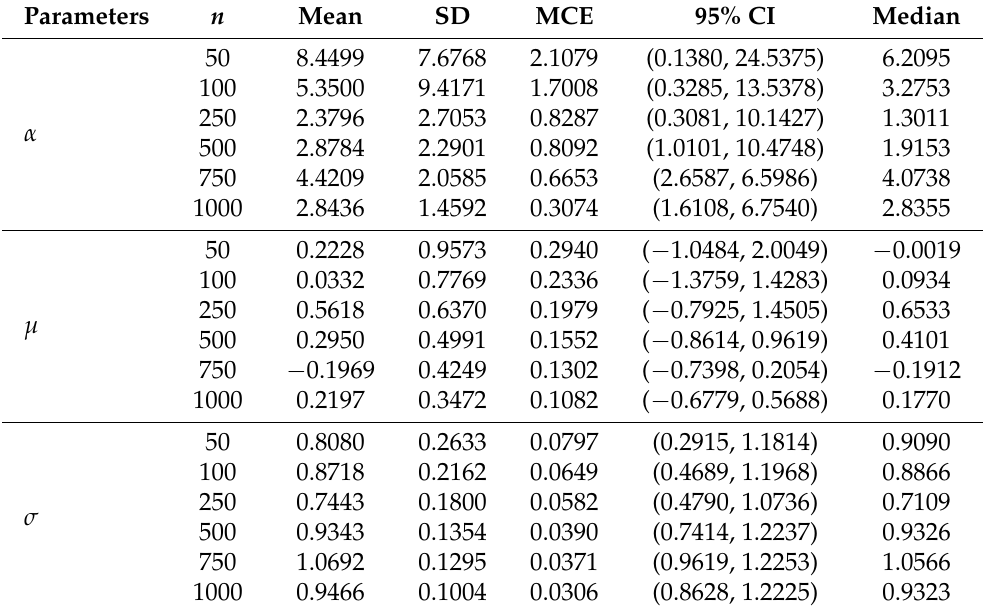
Table 7. Posterior summary results for ( α = 3.5, µ = 0, σ = 1).